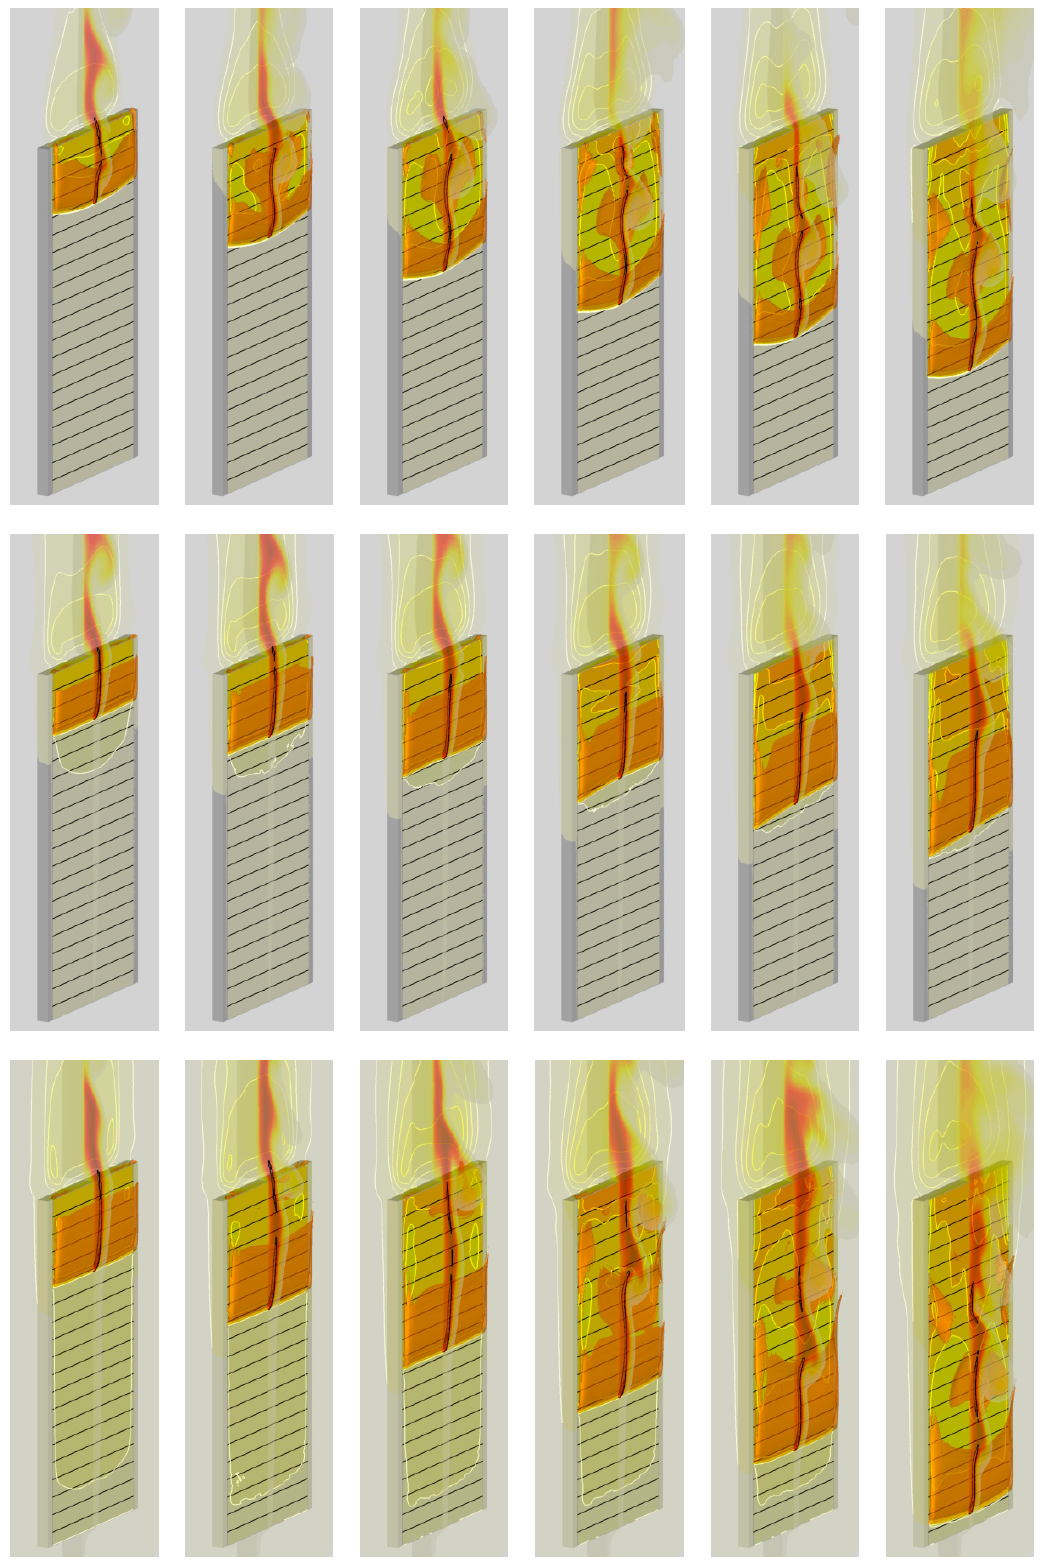
Figure 20. Predicted flame shape and instantaneous distributions of sample surface temperature and gas temperature at the vertical symmetry plane (with the heat release rate levels of 20, 40, 60, 80, 120 MW/m 3 ) at time instants of 20, 40, 60, 80, 100, and 120 s. Heater temperature: top —300 K; middle —400 K; bottom —500 K.